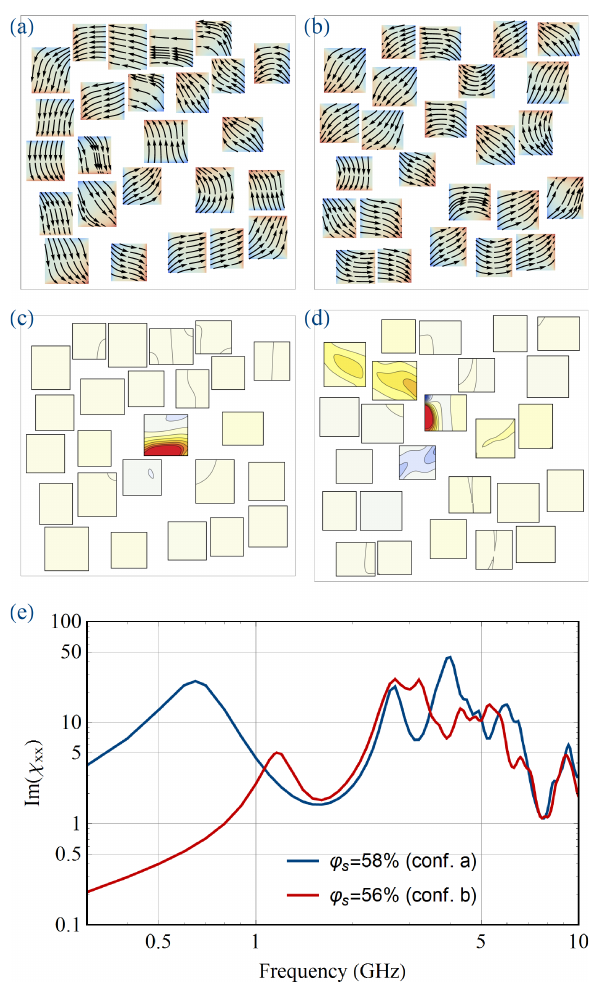
Figure 10. Disordered assemblies of nanoplatelets numerically generated with a surface content ϕ s = 58% (a) and ϕ s = 56% (b). (e) Im( χ xx ) spectra for the two above described configurations. Maps of the local susceptibility (imaginary part) associated with the low-frequency resonance for the ϕ s = 58% (c) and ϕ s = 56% (d) configurations. The color code is the same as in Fig.2.